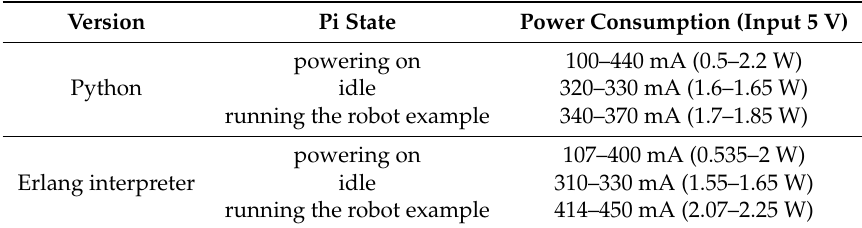
Table 16. Power consumption for both